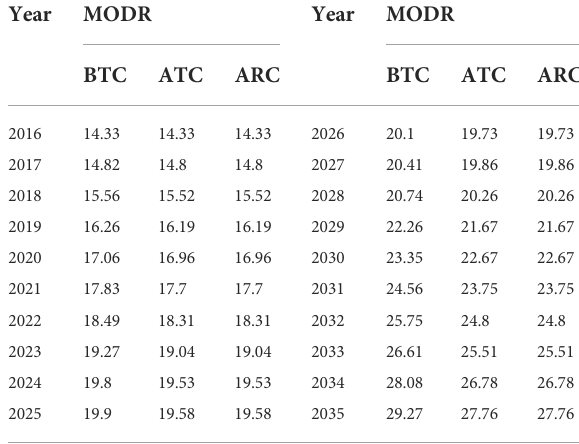
TABLE 4 Prediction results of the MODR for 2016 – 2035